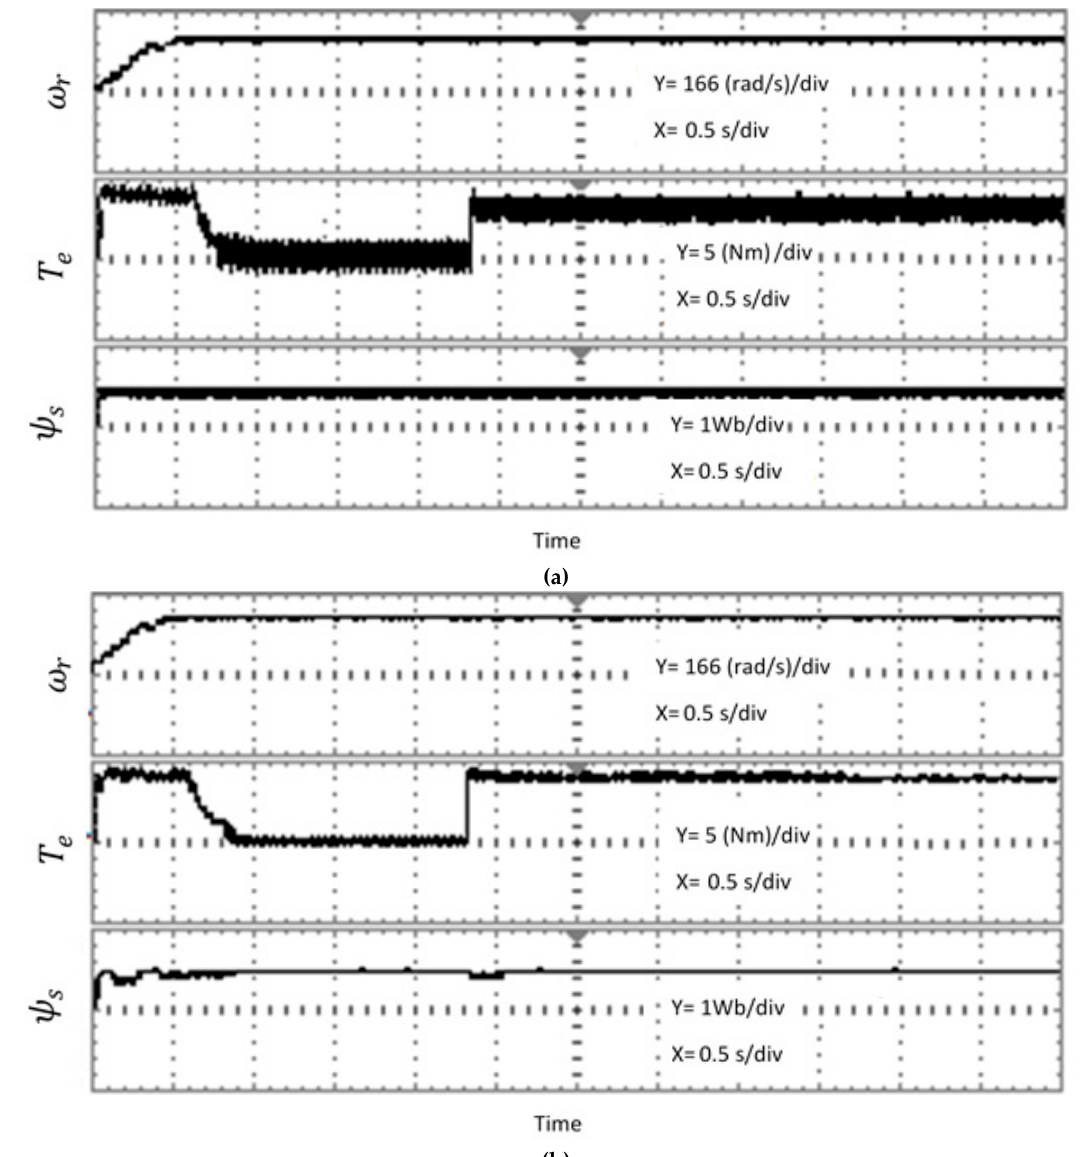
Figure 11. Load injection experiment of 6PIM, controlled by duty cycle control strategy ( a ) and proposed method ( b ).